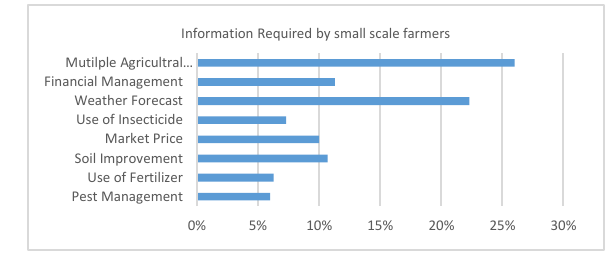
Figure 3: Availability of personalized agro-advice